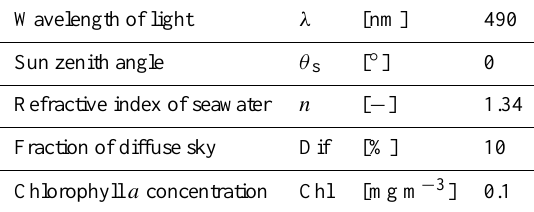
Table 1. Underlying data for radiative transfer